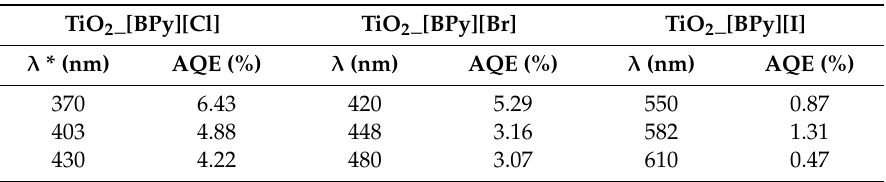
Table 3. Apparent quantum e ffi ciency (AQE) of TiO 2 samples modified by ionic liquids containing halogen